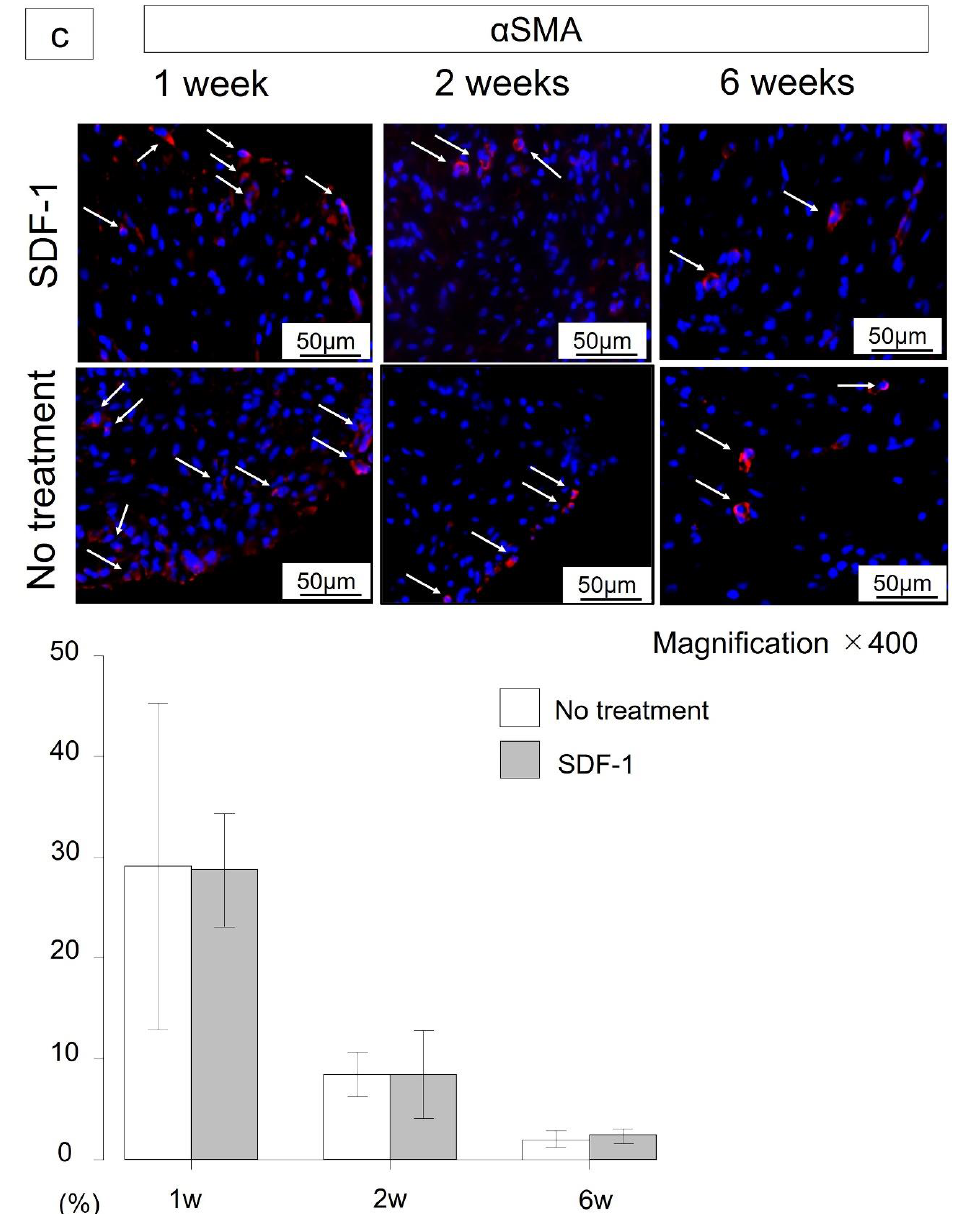
Figure 3. Immunohistochemical examination 1, 2 and 6 weeks after meniscectomy. Blue fluorescence is indicative of 4 (cid:48) ,6-diamidino-2-phenylindole (DAPI). Scale bar indicates 50 µ m. ( a ) Immunofluorescent staining of CD68 for regenerated meniscus. Green fluorescence indicates CD68 (arrows). At 1 week after meniscectomy, CD68-positive cells in the stromal-cell-derived factor-1 (SDF-1) group were significantly higher than in the no-treatment group (CD68: 9.1% vs. 17.7%, p = 0.03). There was no significant difference between both groups at 2 and 6 weeks ( p = 0.421, 0.737). ( b ) Immunofluorescent staining of CD163 for regenerated meniscus. Red fluorescence indicates CD163 (arrows). CD163-positive cells in the SDF-1 group were significantly higher than in the no-treatment group at 1 week after meniscectomy (8.6% vs. 5.7%, p = 0.04). CD163-positive cells in the SDF-1 group were still significantly higher than in the no-treatment group (5.9% vs. 1.7%, p = 0.015) at 2 weeks after meniscectomy. At 6 weeks after meniscectomy, the percentage of positive cells decreased to approximately 1%. ( c ) Immunofluorescent staining of α -smooth muscle actin ( α SMA) for regenerated meniscus. Red fluorescence indicates α SMA (arrows). There was no significant difference between both groups throughout the study. White bar: no-treatment group. Gray bar: SDF-1 group. Bars show the mean ± SD (n = 5 at 1 and 2 weeks, n = 7 at 6 weeks). * p <